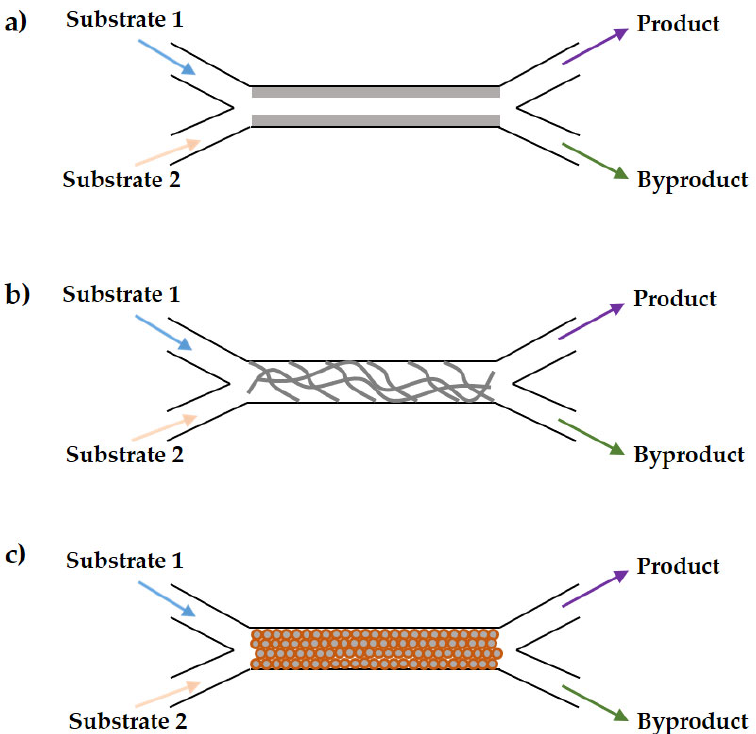
Figure 2. Approaches for enzyme immobilization within microchannels ( a ) wall-coated types, ( b ) monolithic types, and ( c ) packed-bed type.